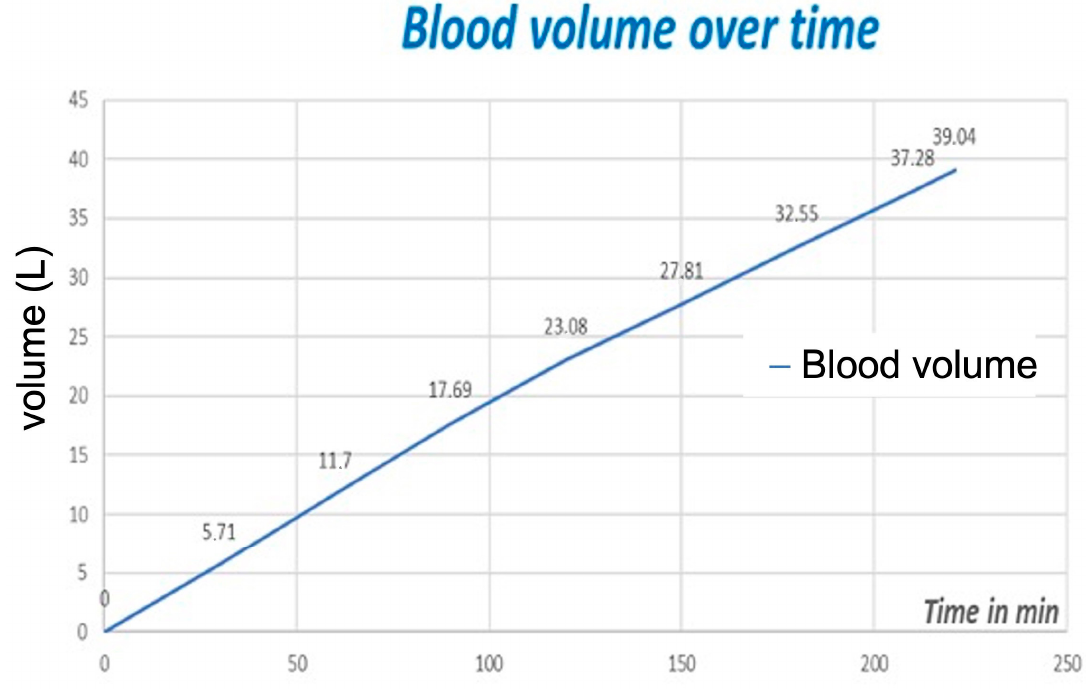
Figure 4. Blood volume processed: in total, 39.04 L over 221 min (treatment